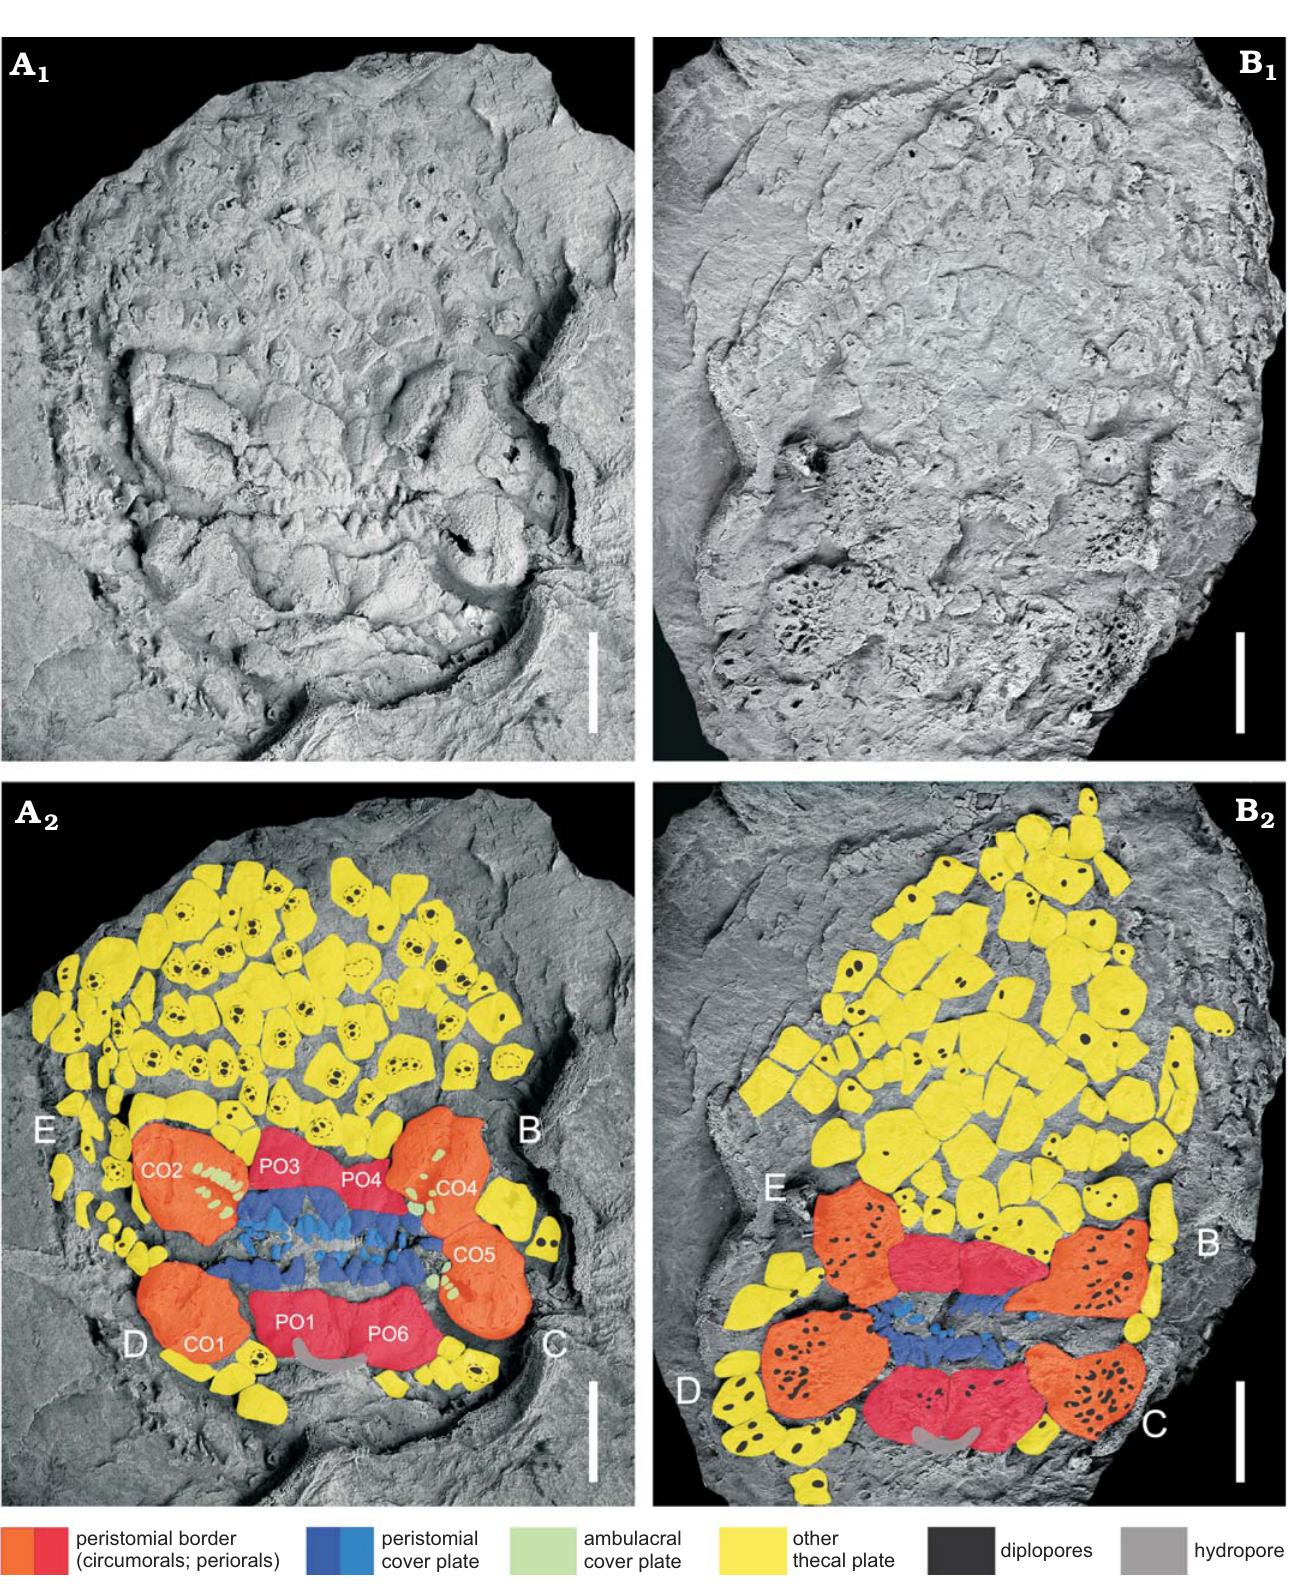
Fig. 6. Oral surface of the diploporite blastozoan Lepidocalix pulcher Termier and Termier, 1950a (MUA. 1024020); Middle Ordovician, Stita, Algeria. A . Four peri-orals (PO1, PO3, PO4, and PO6) between four circum-orals (CO1, CO2, CO4, and CO5), peristome partially covered by small